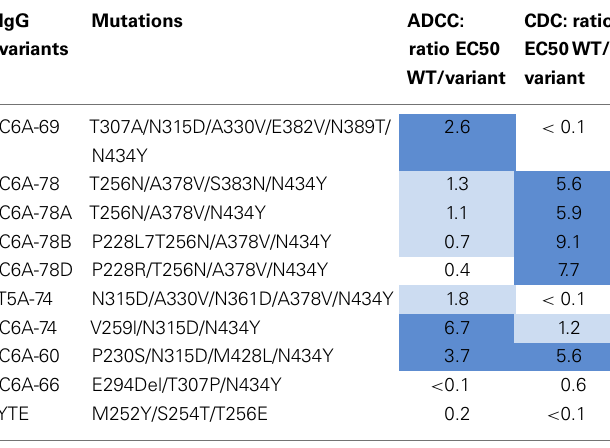
Table 5 |ADCC and CDC results of IgG-WT and IgG variants produced inYB2/0 cells